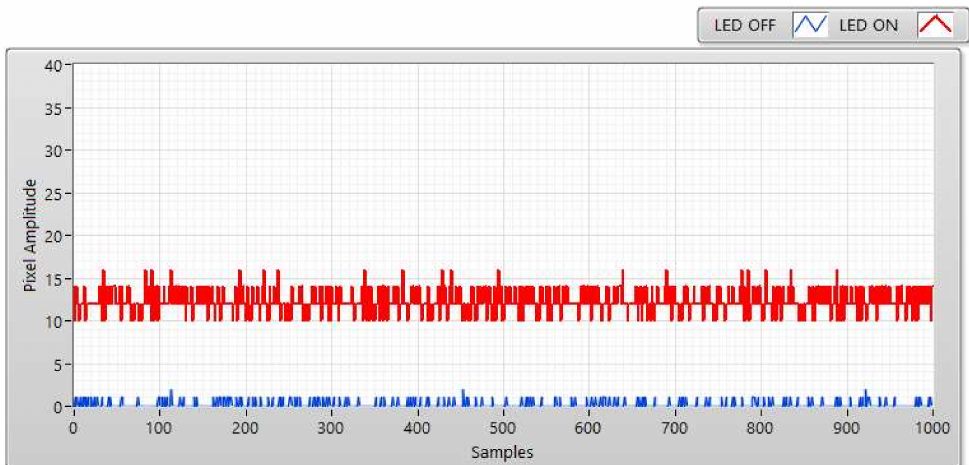
Figure 9. SNR measurement with Point Gray rolling shutter camera at communication distance of 20 m and exposure time of 50 µ